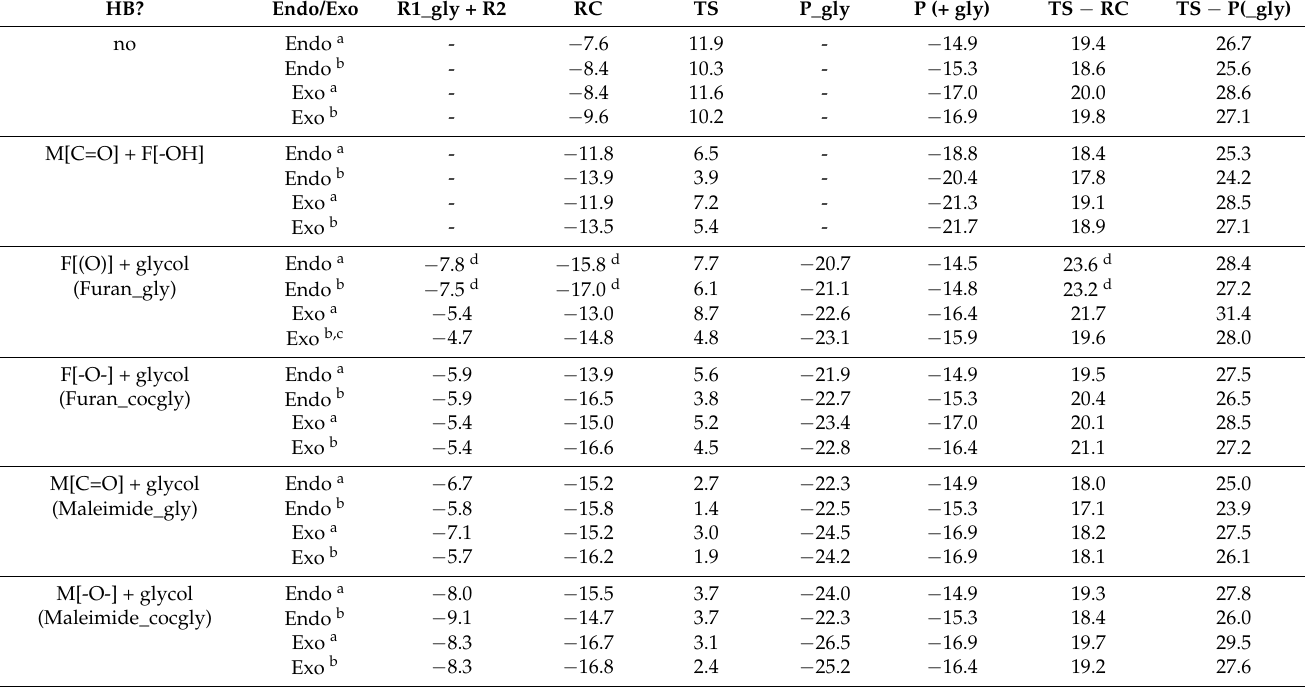
Table 3. The energetics of the Diels–Alder reactions using enthalpies H at 298.15 K, with and without addition of ethylene glycol. Hydrogen bond (HB) is formed with Furan (F) or Maleimide (M) (C=O: carbonyl; -OH: hydroxyl; (O): ring oxygen; -O-: ether). Values are relative to the separate reagents and given in kcal mol − 1 . R1_gly: reactant complex between first reactant and glycol; RC: reactant complex of R1_gly with second reactant R2; TS: transition state; P_gly: product complex with glycol; P: